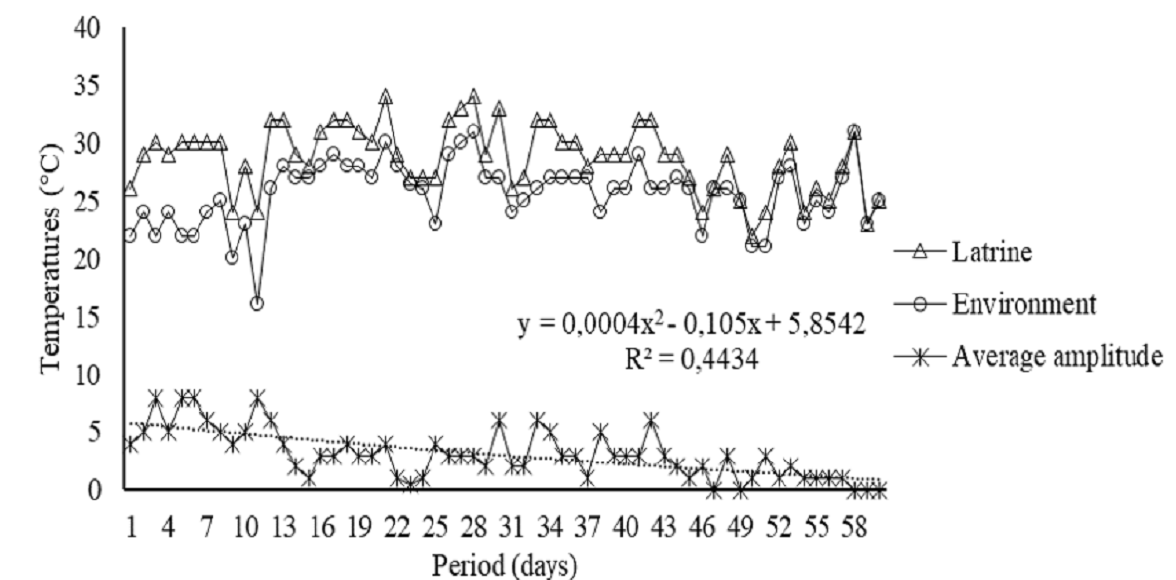
Figure 5. Average temperature of the external environment, the interior of organic matter, and temperature range (°C) at the municipality of Campo Grande, Mato Grosso do Sul,